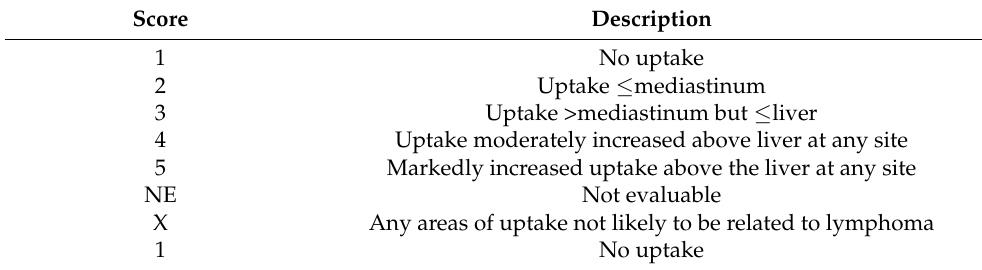
Table 3. Modified Lugano five-point scale